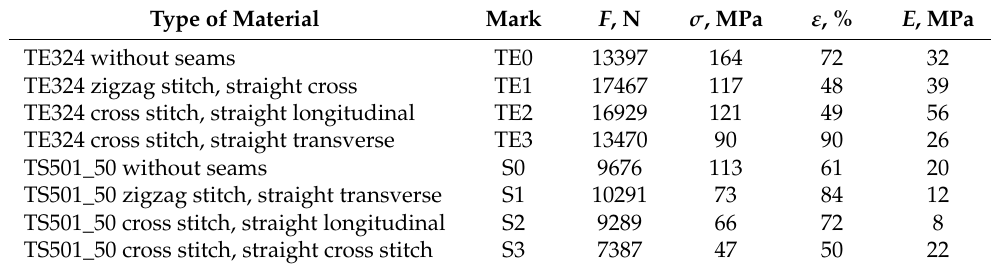
Table 2. Summary of the obtained results from the static tensile test; Source: Own research (2021).